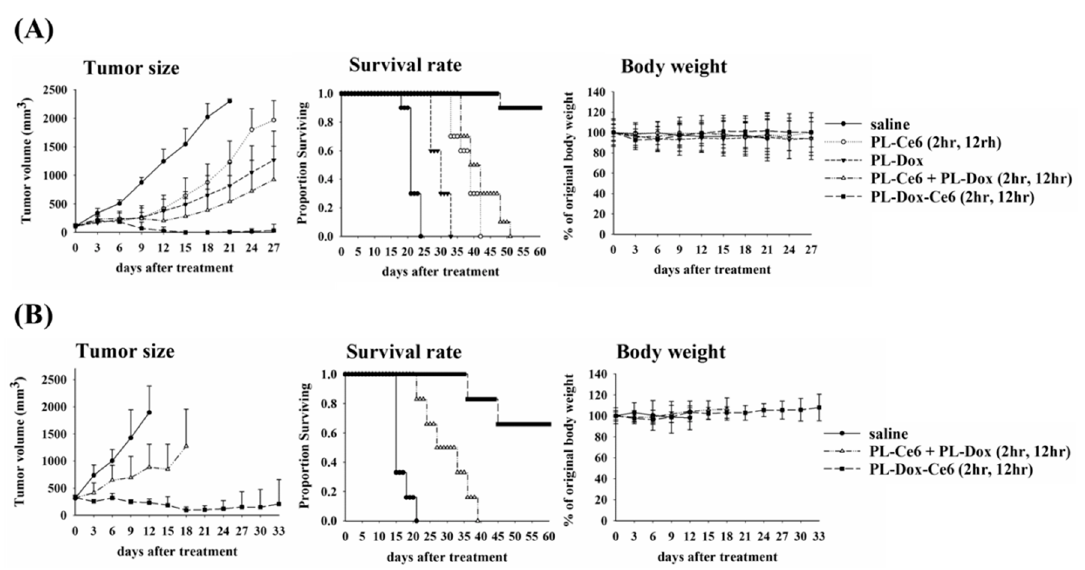
Figure 3. Therapeutic efficacy of C26 tumor-bearing mice that received a single dose of PL-Dox-Ce6 and two doses of light irradiation. One dose of PL-Dox-Ce6 (Ce6: 1.75 mg/kg; Dox: 8.31 mg/kg) was administrated intravenously into tumor-bearing mice. Two doses of light irradiation (100 J / cm 2 ) were applied onto the tumor at 2 and 12 h post drug administration. ( A ) The average size of initial tumor was 100 mm 3 before drug administration ( N = 10). ( B ) The average size of initial tumor was 300 mm 3 before drug administration ( N = 6). Left panel, tumor size; Middle panel, survival rate; Right panel, body weight. The results are represented as the mean ± S.D. for each group.